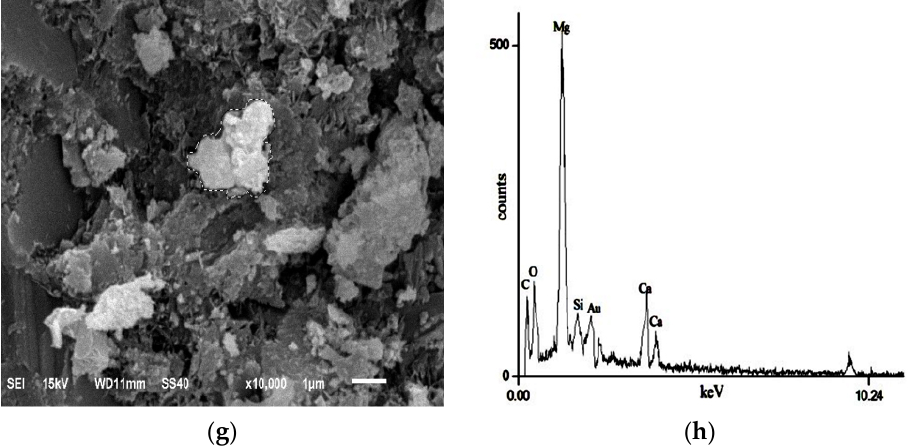
Figure 8. SEM images of cement paste mixed with MgO (65s) at 20 °C: ( a ) MgO, SEM; ( b ) Mg(OH)2, SEM; ( c ) 3d, SEM; ( d ) 3d, EDS; ( e ) 7d, SEM; ( f ) 28d, SEM ; ( g ) 90d, SEM; ( h ) 90d, EDS.